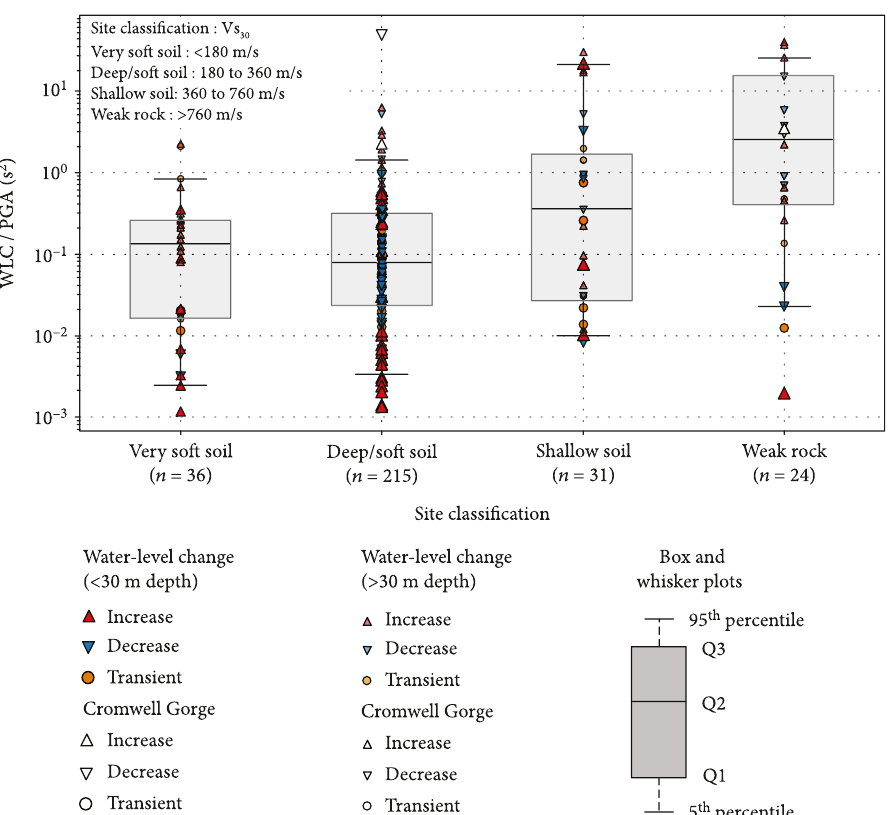
[77]. Monitoring well depths 30